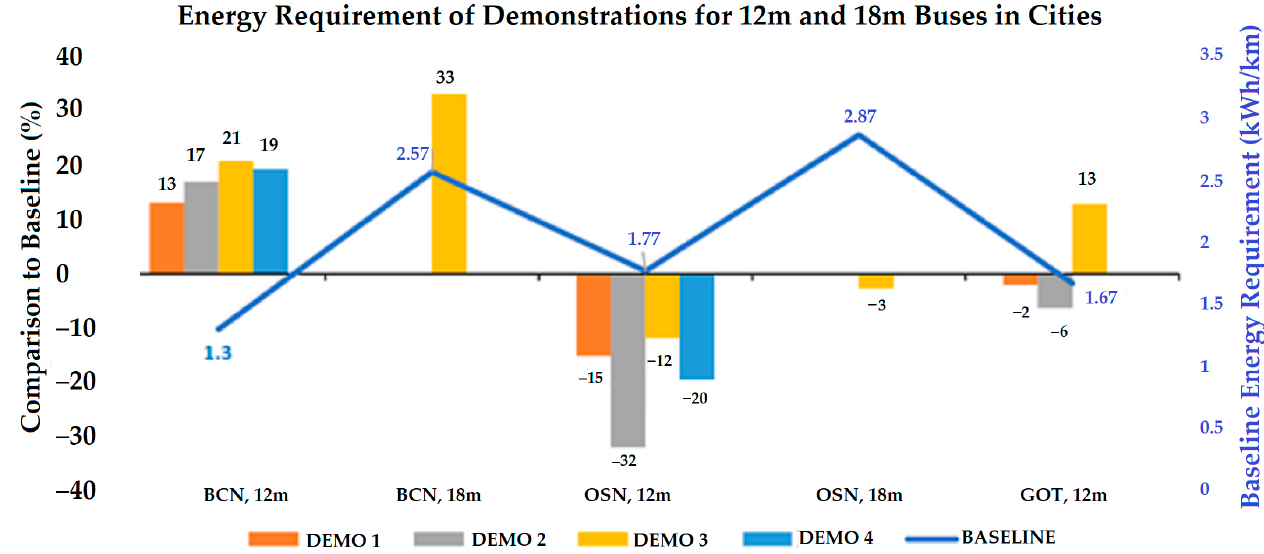
Figure 3. Comparison of the energy requirement for 12 m and 18 m buses in Barcelona, Osnabruck, and Gothenburg between the standard and actual driving cycles.